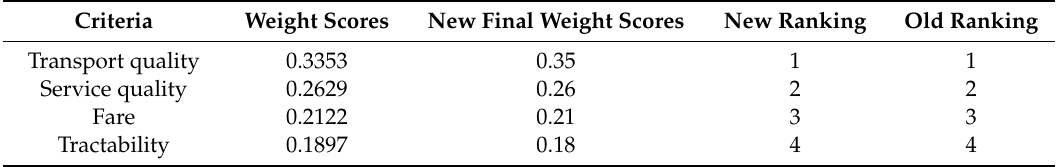
Table 7. Weight scores and ranking after the sensitivity check for level 1.